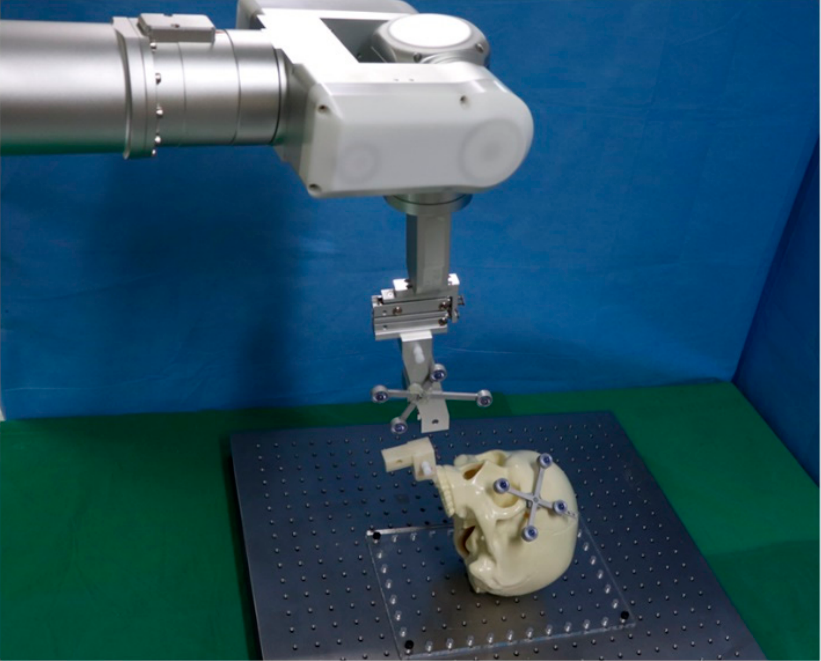
Figure 1. A robot arm combined with a navigation system for maxillary orthognathic surgery. Image-guided navigation is done using the optical tracking system (OTS) (POLARIS SPECTRA, Northern Digital Inc., ON, Canada) [13]. The target and actual positions of the maxilla are visualized in real time and the discrepancy between two positions at the five dental landmarks is also provided (Figure